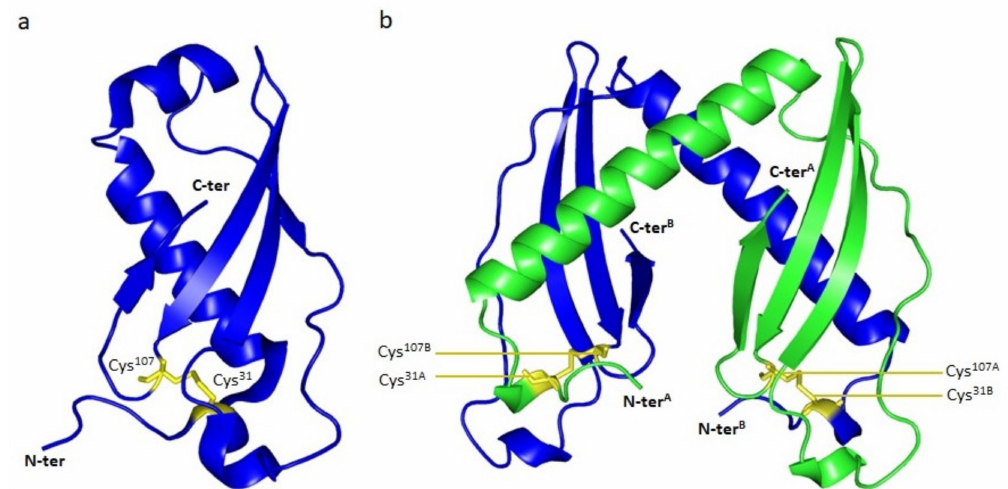
Figure 8. 3D-structures of Cmi. ( a ) Structure of Cmi as a monomer (PDB entry, 2XGL). The N-terminal (N-ter) and C- terminal (C-ter) ends are indicated. The cysteinyl residues 31 and 107 (Cys31 and Cys107), responsible for the formation of the disulfide bond, are colored in yellow and represented as sticks. ( b ) Structure of Cmi as a dimer (PDB entry, 4AEQ). Each protomer is colored differently (green for protomer A and blue for protomer B). The N-terminal (N-ter A and N-ter B ) and C-terminal (C-ter A and C-ter B ) of both protomers are indicated. The residues involved in the formation of intermolecular disulfide bridges are identified. Residues Cys 31A and Cys 107B , belonging to monomers A and B, respectively, form the first disulfide bridge. Residues Cys 31B and Cys 107A form the second one. The structures of Cmi as monomer and dimer are represented in cartoon. The figure was prepared with the atomic coordinates from the PDB by using PyMOL (DeLano